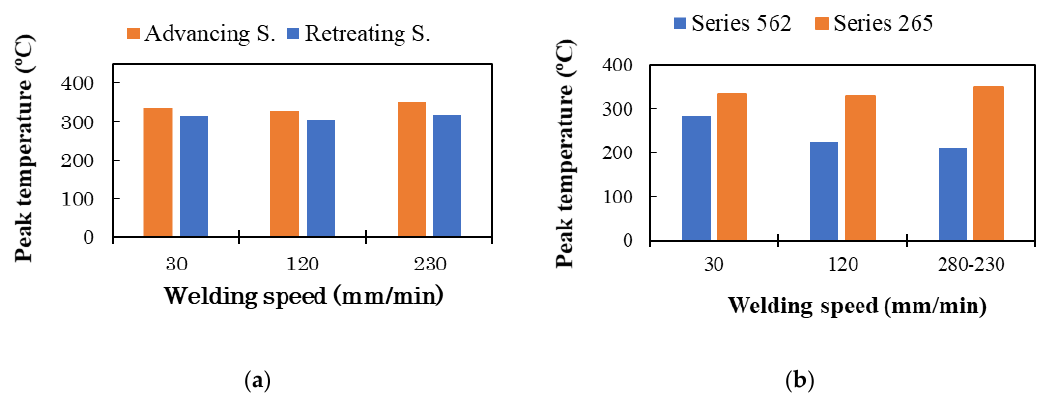
Figure 4. Peak temperature measured ( a ) on the advancing and retreating sides of the weld series 265 and ( b ) on the advancing side of the 562 and 265 weld series.